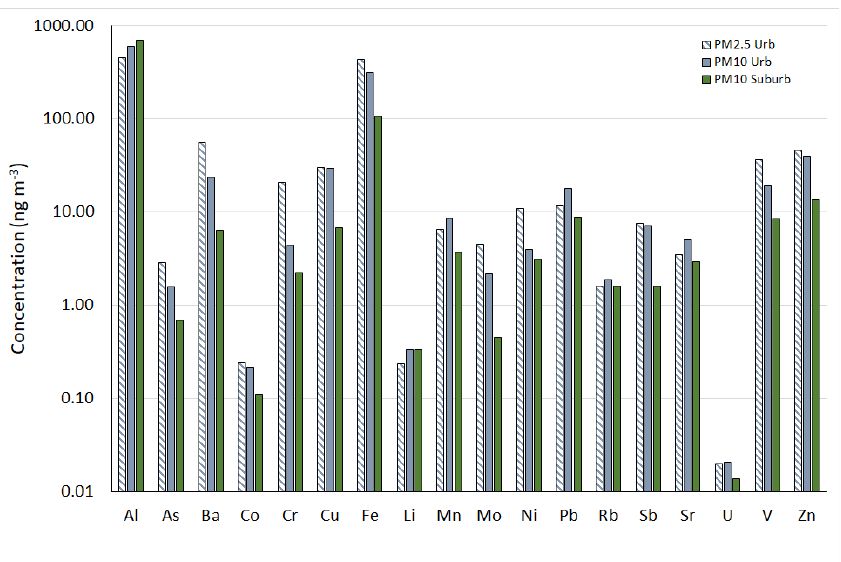
Figure 2. Average distribution of trace element concentrations in PM 2.5 and PM 10 . Data are expressed in ng m -3 .